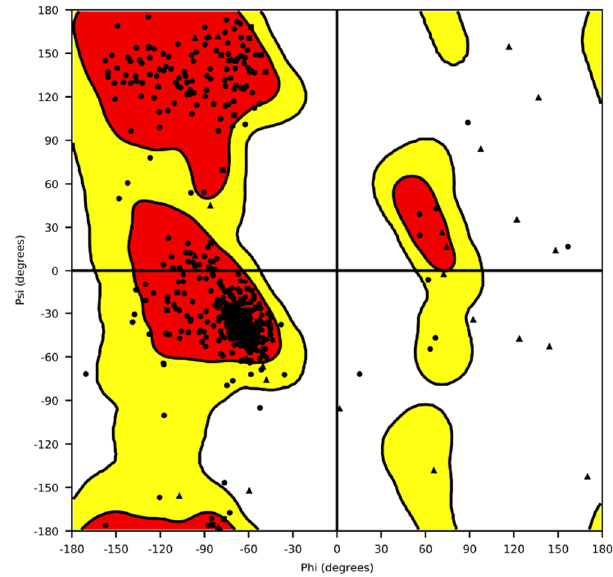
Figure 5. Ramachandran plot of the three-dimensional model for Pyricularia oryzae cytochrome bc1 complex. Red and yellow regions are respectively favored and allowed regions. Triangles refer to G, squares to P, and dots to the remaining amino acids.